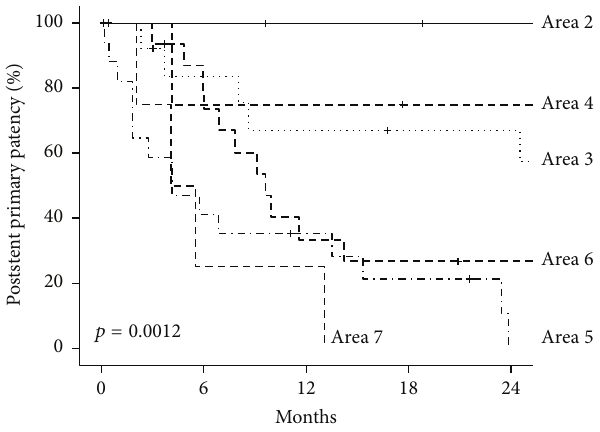
Figure 4: Postintervention primary patency for stents placed at seven treatment areas. Area 2: arteriovenous anastomosis; Area 3: juxta-anastomosis; Area 4: forearm venous outflow; Area 5: upper arm venous outflow; Area 6: cephalic arch; Area 7: central